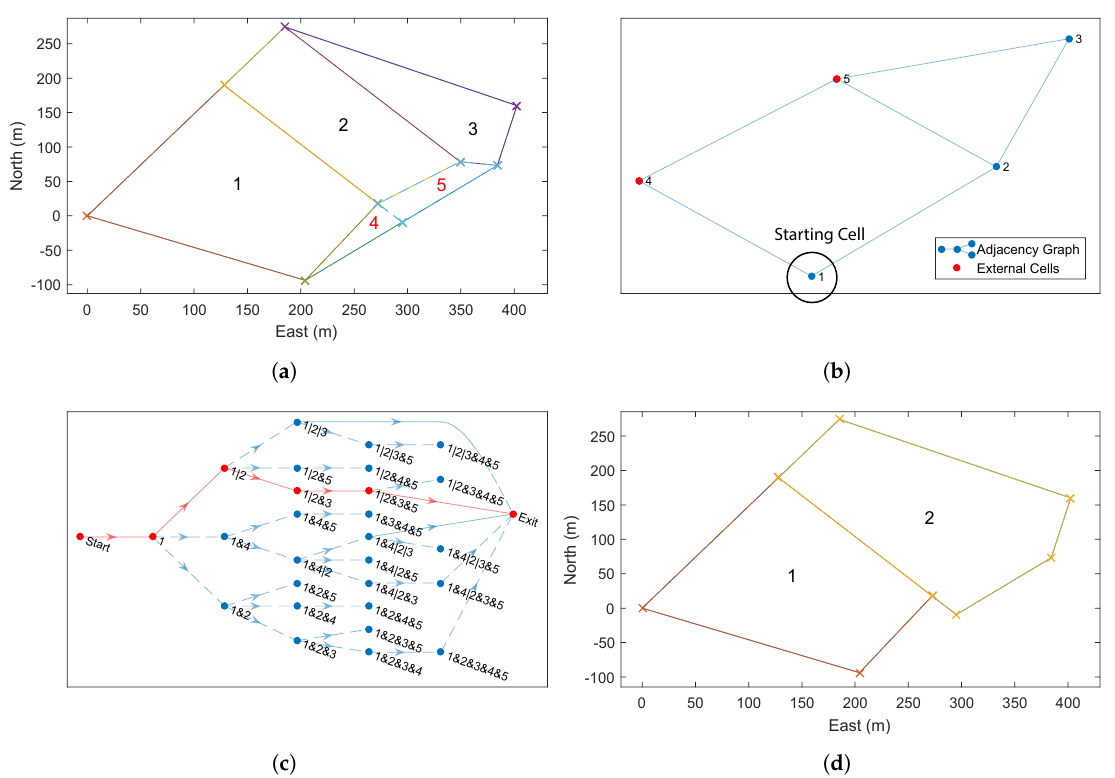
Figure 14. “Bottom Up” Dynamic Programming Recombination Example. ( a ) decomposition of ROI with two external polygons; ( b ) adjacency graph of decomposed polygons; ( c ) full search network using dynamic programming (Notation: “1|2” denotes that cells one and two are separate polygons, “1&2” denotes that they have been recombined); ( d ) recombined ROI into two polygons. Note that only one (#5) of the two optional cells has been chosen by the